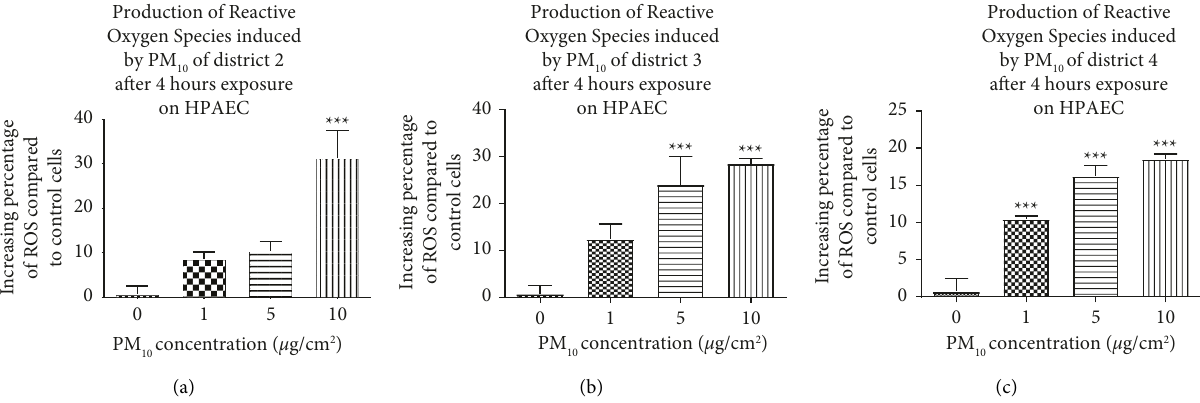
Figure 2: Production of ROS in HPAEC cells after 4 hours of exposure to PM 10 of districts 2 (a), 3 (b), and 4 (c) of Ouagadougou (Burkina Faso). The HPAEC cells were seeded for 24 hours and then treated with different concentrations of PM 10 (1.5, 10, 25, and 50 µ g/cm 2 ) for 4 hours. Intracellular ROS production was evaluated by the CM-H2DCFDA probe and measured by spectrofluorimetric method. The percentage increase in ROS is calculated relative to control cells. Data are expressed as means ± SEM of three independent experiments n � 3 (three wells per concentration). The statistical test used is a one-way ANOVA followed by a multiple comparison with Dunnett’s correction, ∗∗∗ p < 0 . 001: significance level compared to control